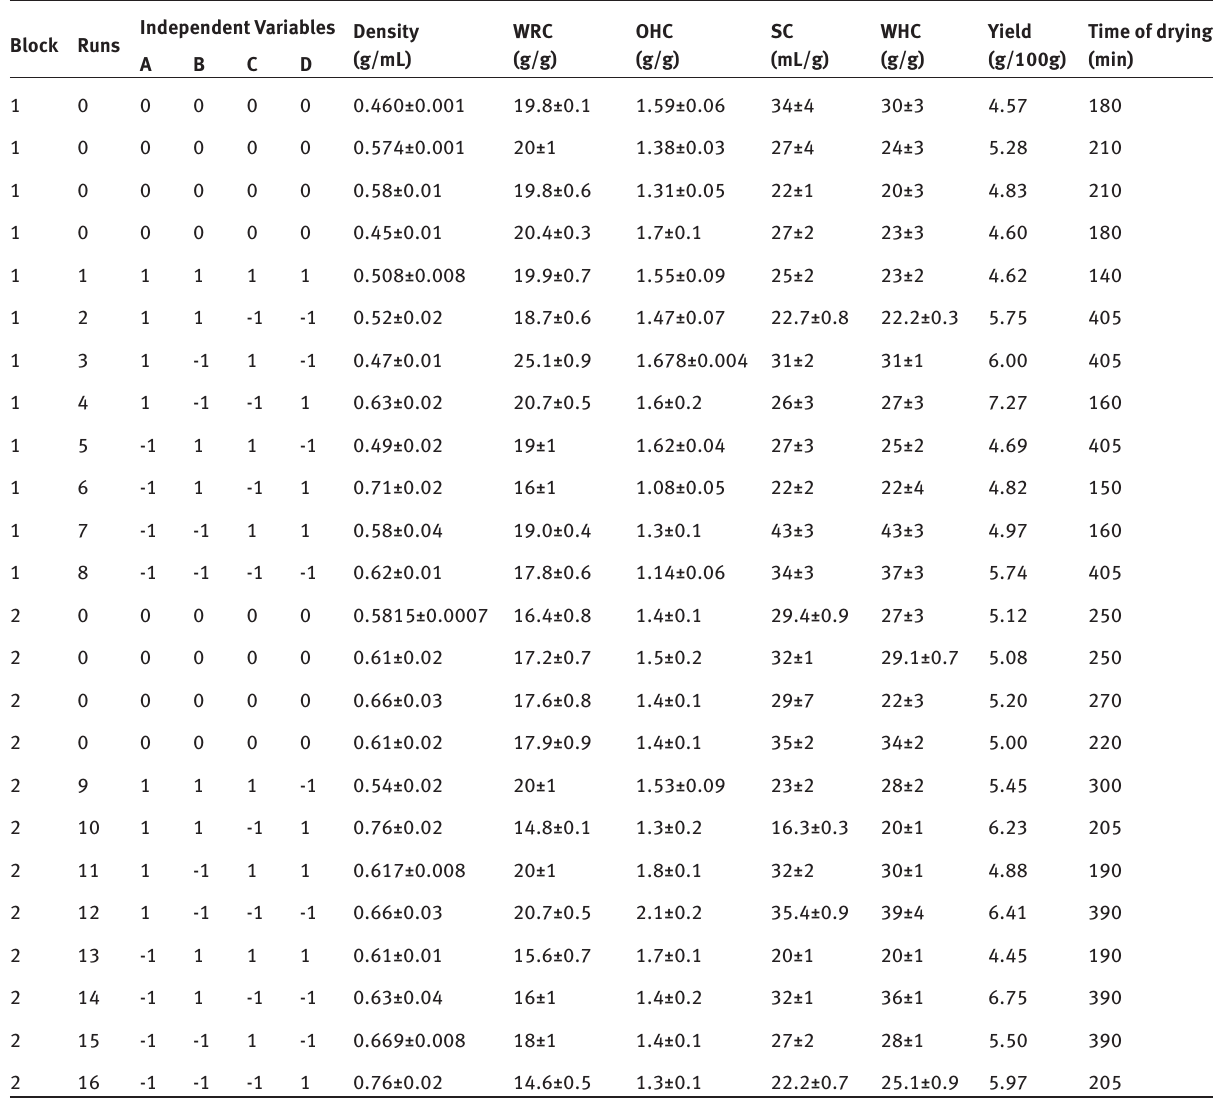
Table 1: Properties of fractions enriched in dietary fiber isolated from (Prunus persica L.) and air dried Independent Variables Density Block Runs